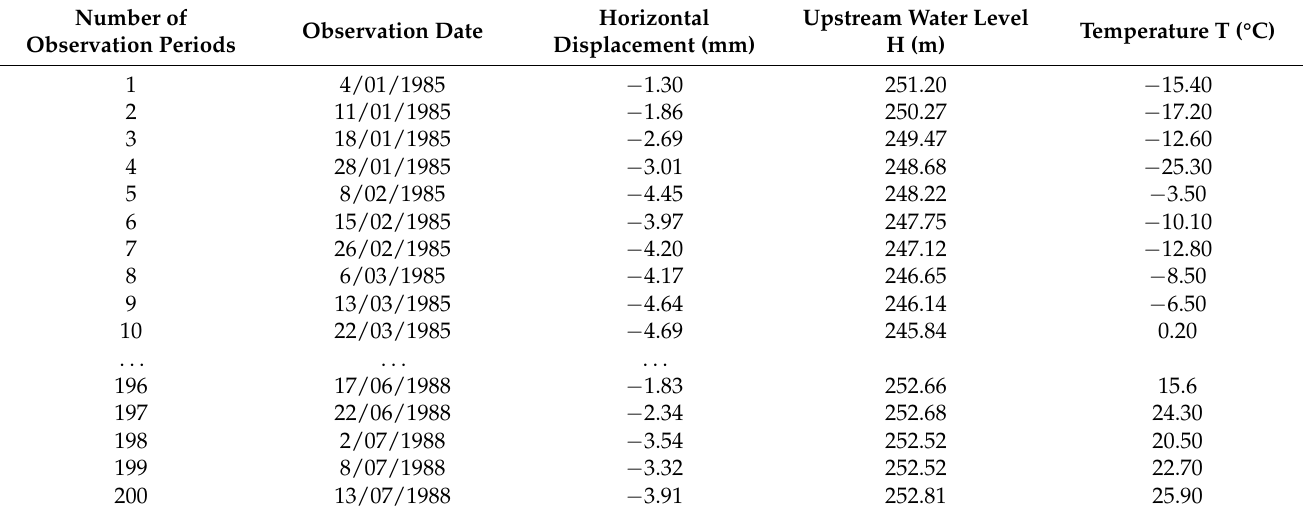
Table 1. Monitoring data of horizontal displacement